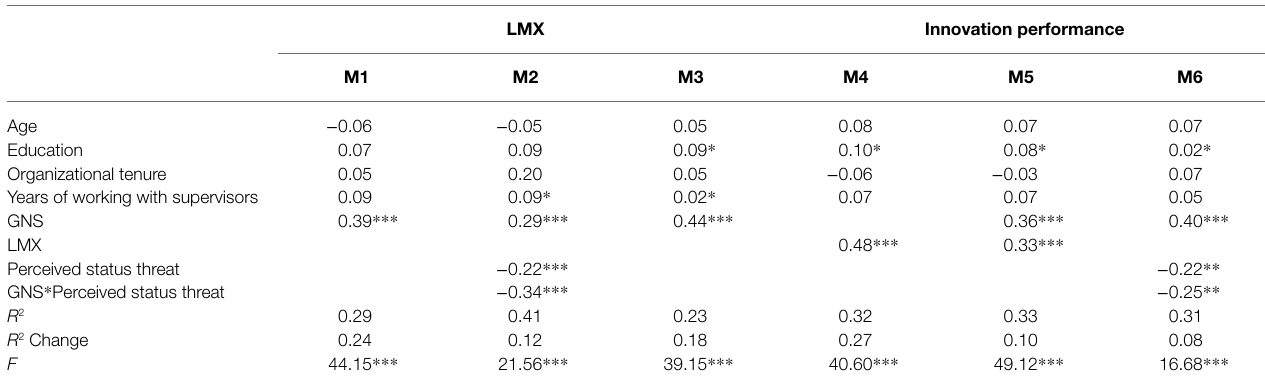
TABLE 3 | Results of the hypothesis